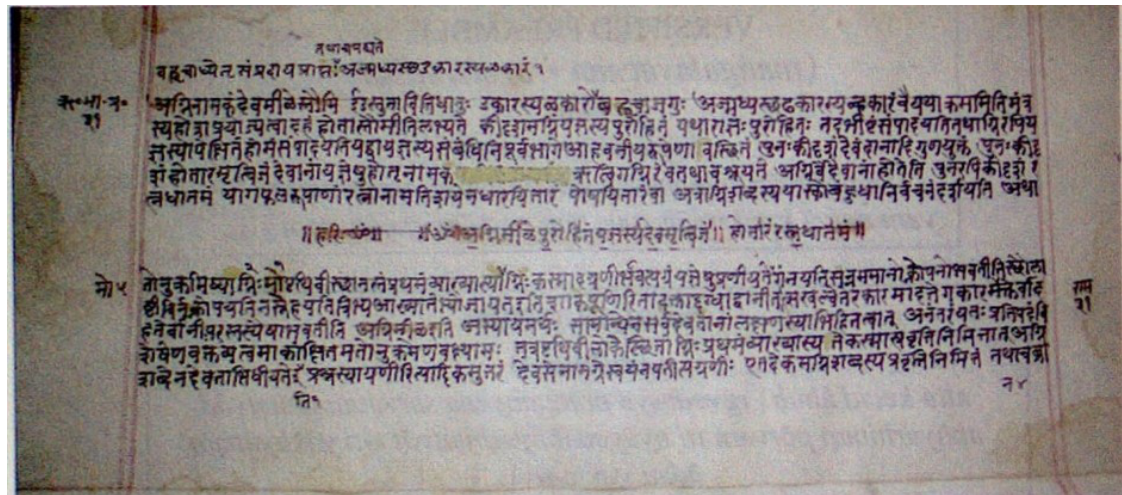
Figure 1 Fol. 31v of a Hs of Sāyaṇas Ṛgvedasamhitābhāṣyabhūmikā, RV I, 1.1 in center, surrounded by commentary (Galewicz 2009,